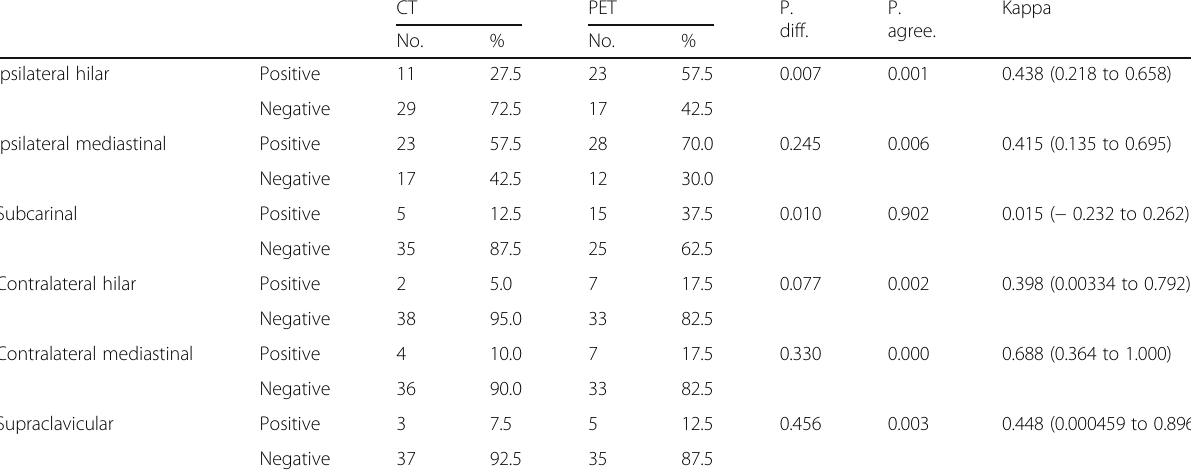
Table 3 Showing the sites of lymph node groups involvement in CT versus PET-CT